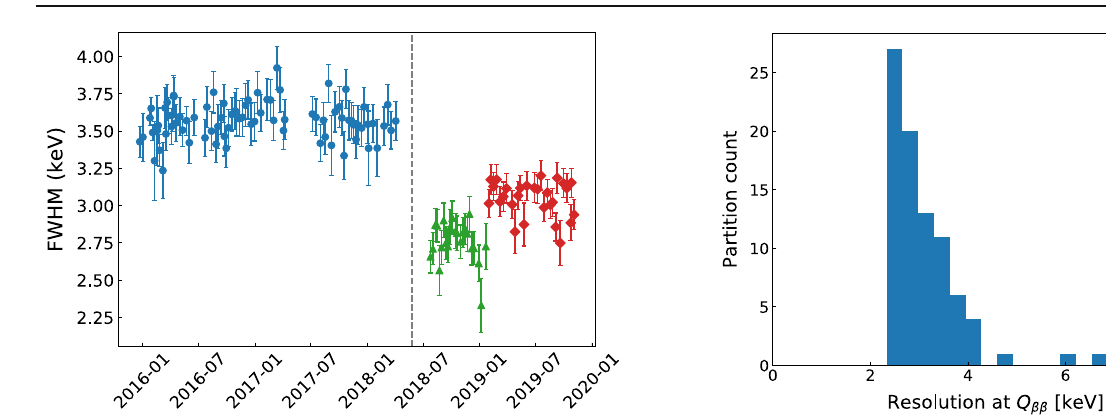
Fig. 4 Distribution of FWHM resolution at Q ββ per detector partition. The detector partitions with resolutions >6keV are due to two